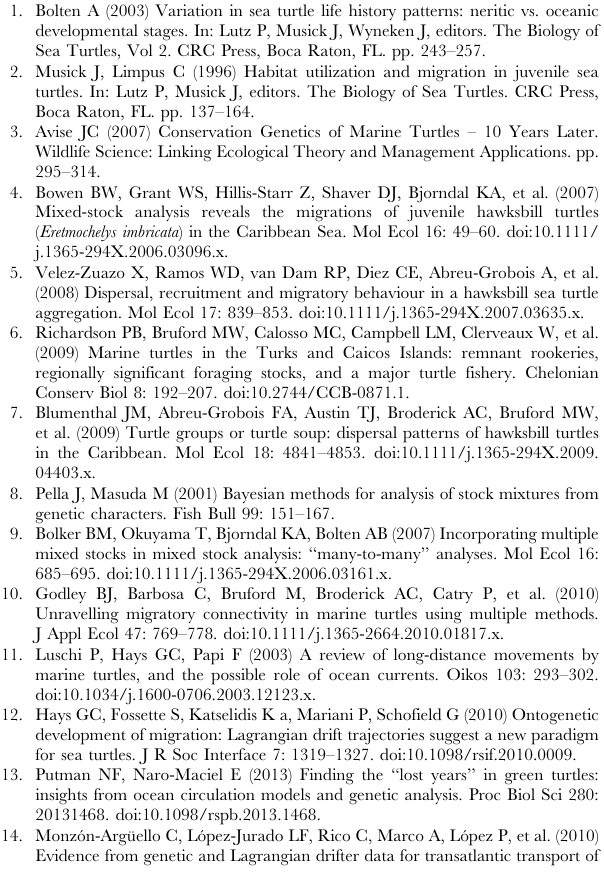
Equatorial Current, GS = Gulf Stream, NA= North Atlantic Current, CN = Canary Current. Table S1 Short haplotype frequencies for Atlantic Ocean hawksbill populations. Longer haplotype (740 bp) names are given when they have no short equivalent. References for genetic data can be found in the